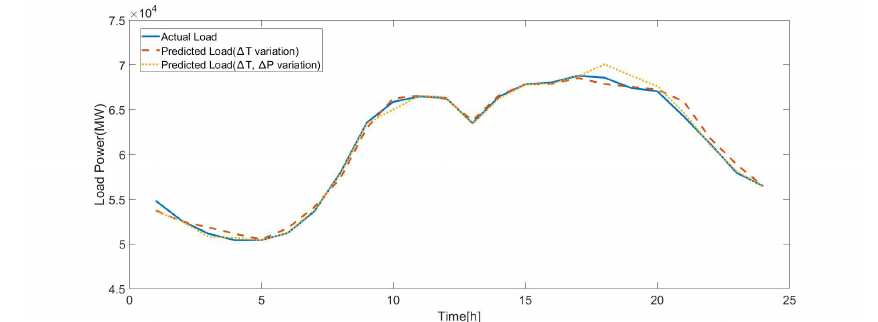
Figure 11. Comparing ∆ P and ∆ T for compensation